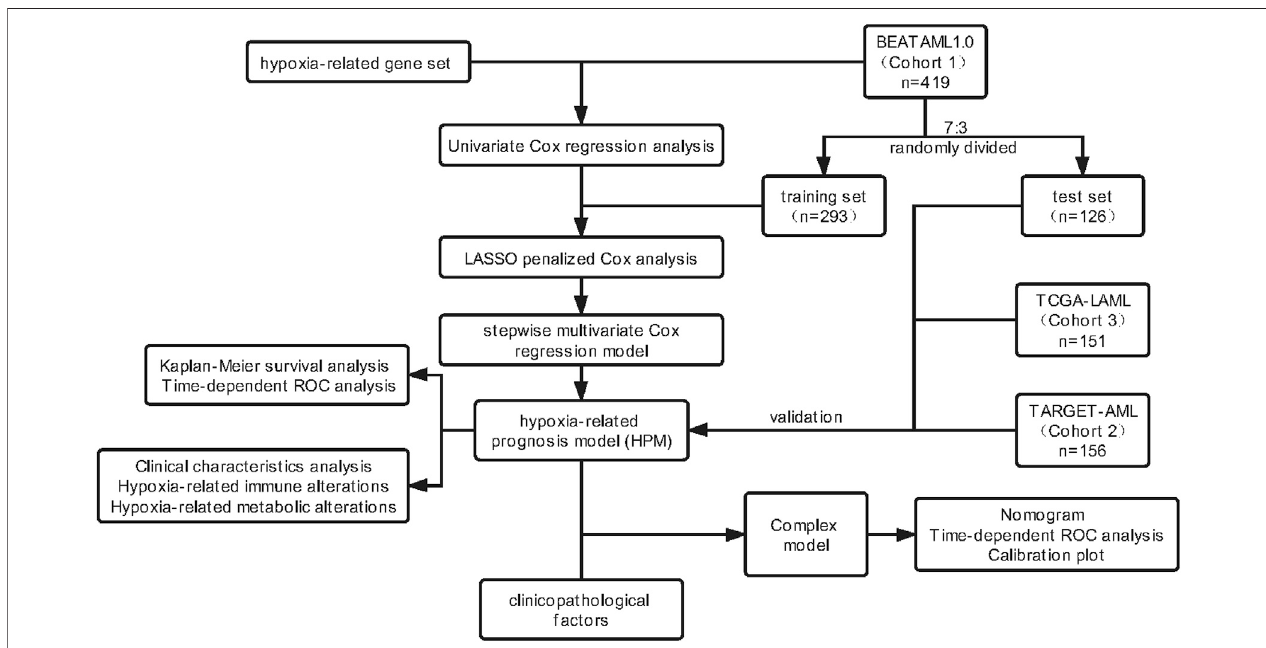
FIGURE 1 | Flowchart of data collection, modeling, and further analysis.